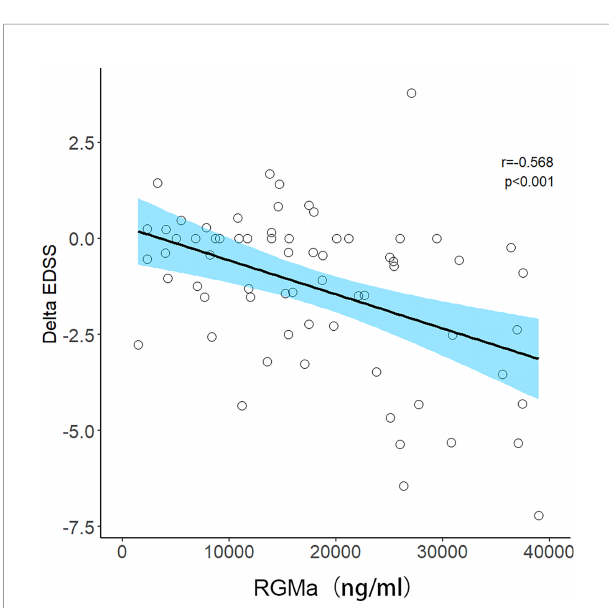
FIGURE 3 | Correlation between serum RGMa level and EDSS score at admission in NMOSD after adjusting for sex, age, total disease course, time from attack to sampling, and number of episodes.